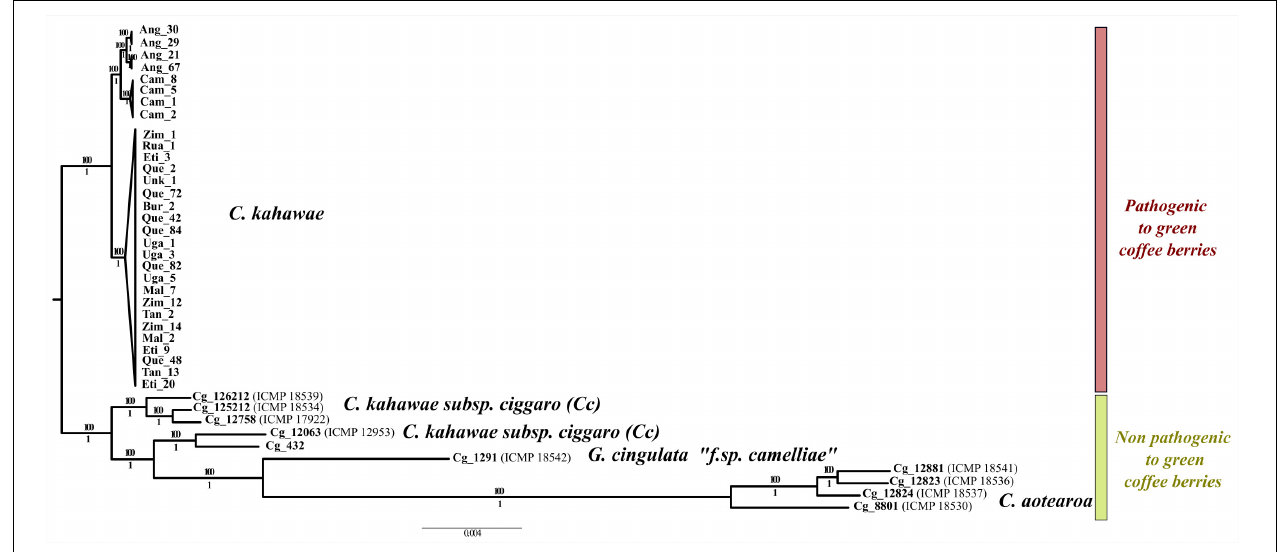
FIGURE 3 | Maximum likelihood phylogenetic tree illustrating the evolutionary relationships among pathogenic and non-pathogenic fungi to green coffee berries. Bootstrap and posterior probability values are provided above and below the branches, respectively.